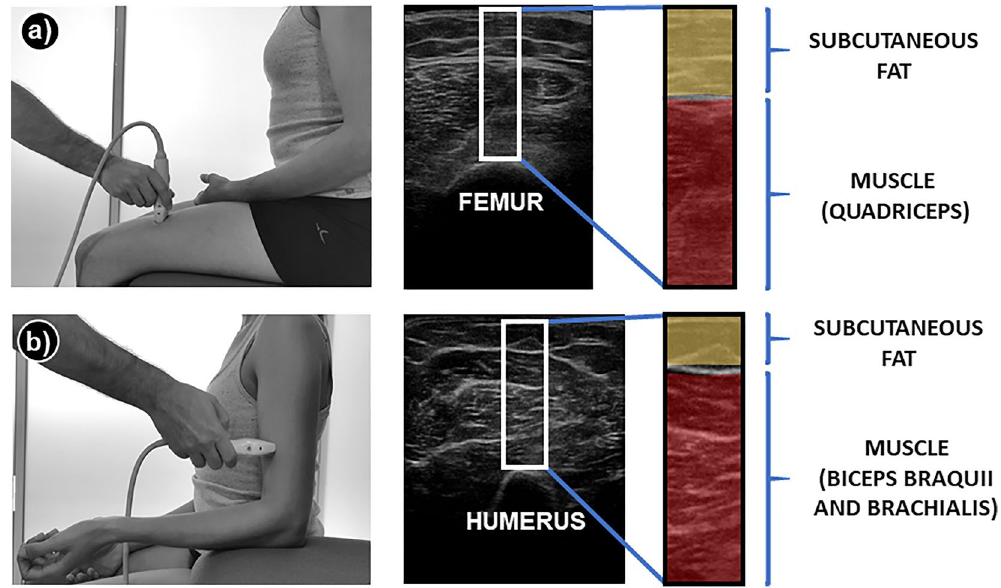
Figure 1. Position of the patient and ultrasound probe and range of interest (white rectangle) of sample images ( a : quadriceps; b :